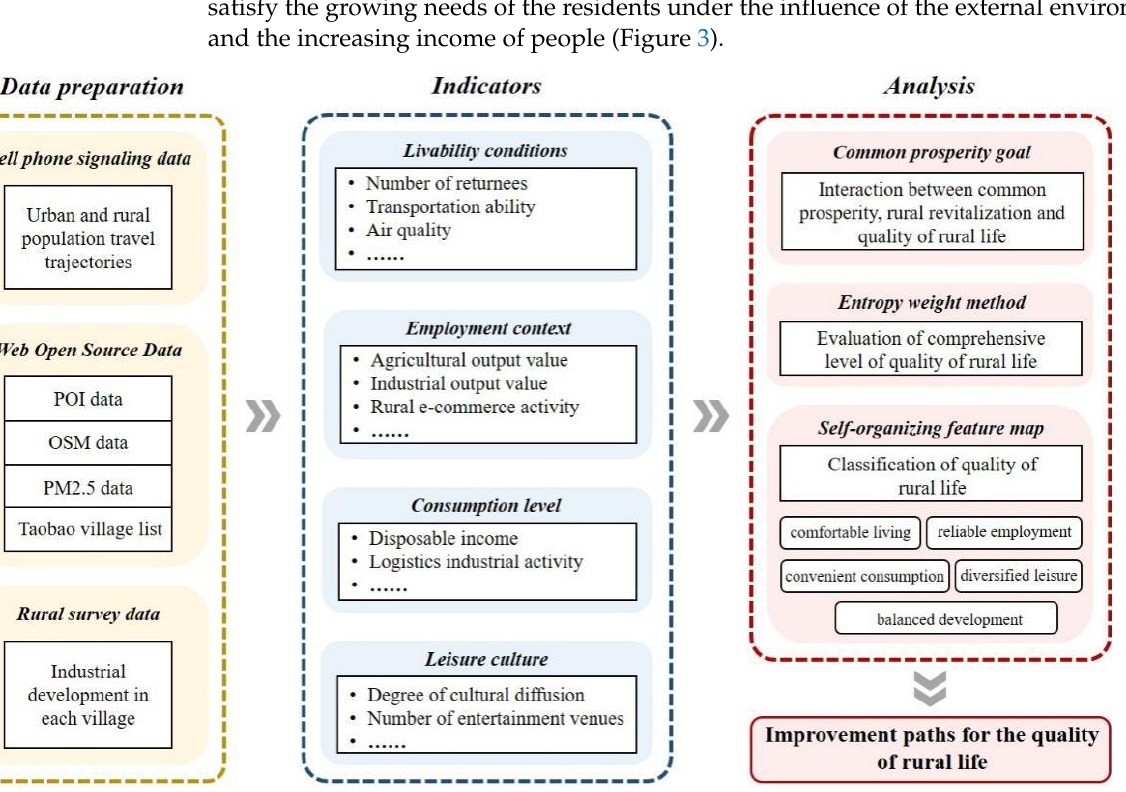
Table 1. Evaluation index system for QRL in Lin’an District and weights of indexes. Target